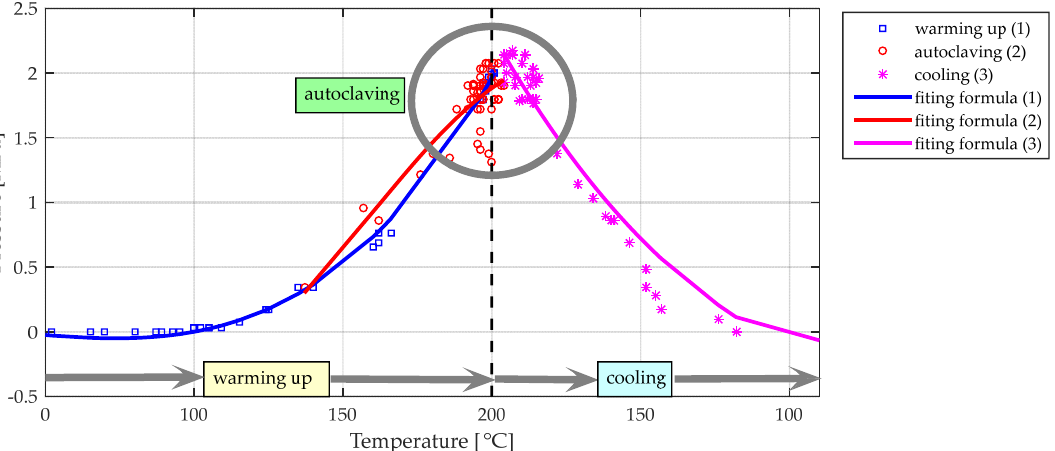
Figure 7. Autoclaving conditions used in laboratory setting during the brick production (3 processes with 10 elements each). &#x А ;